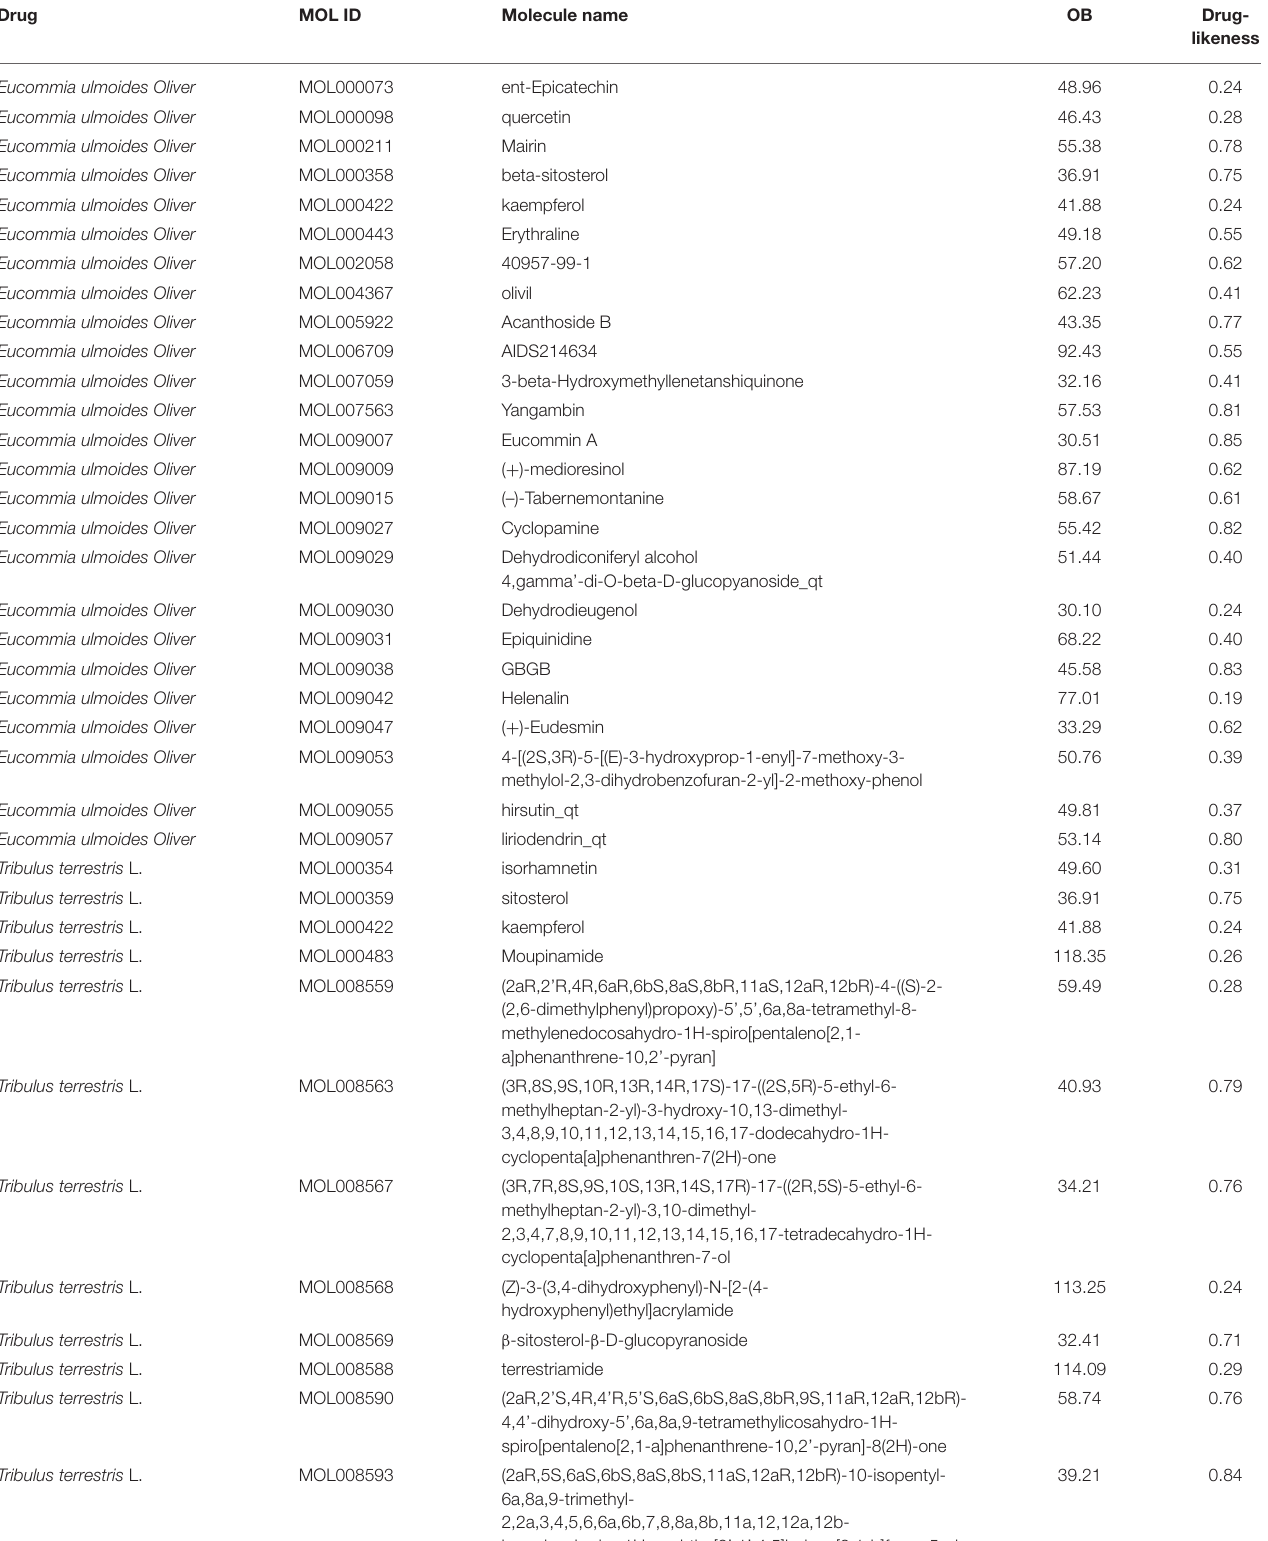
TABLE 1 | Detailed information on active compounds from Eucommia ulmoides Oliver and Tribulus terrestris L.